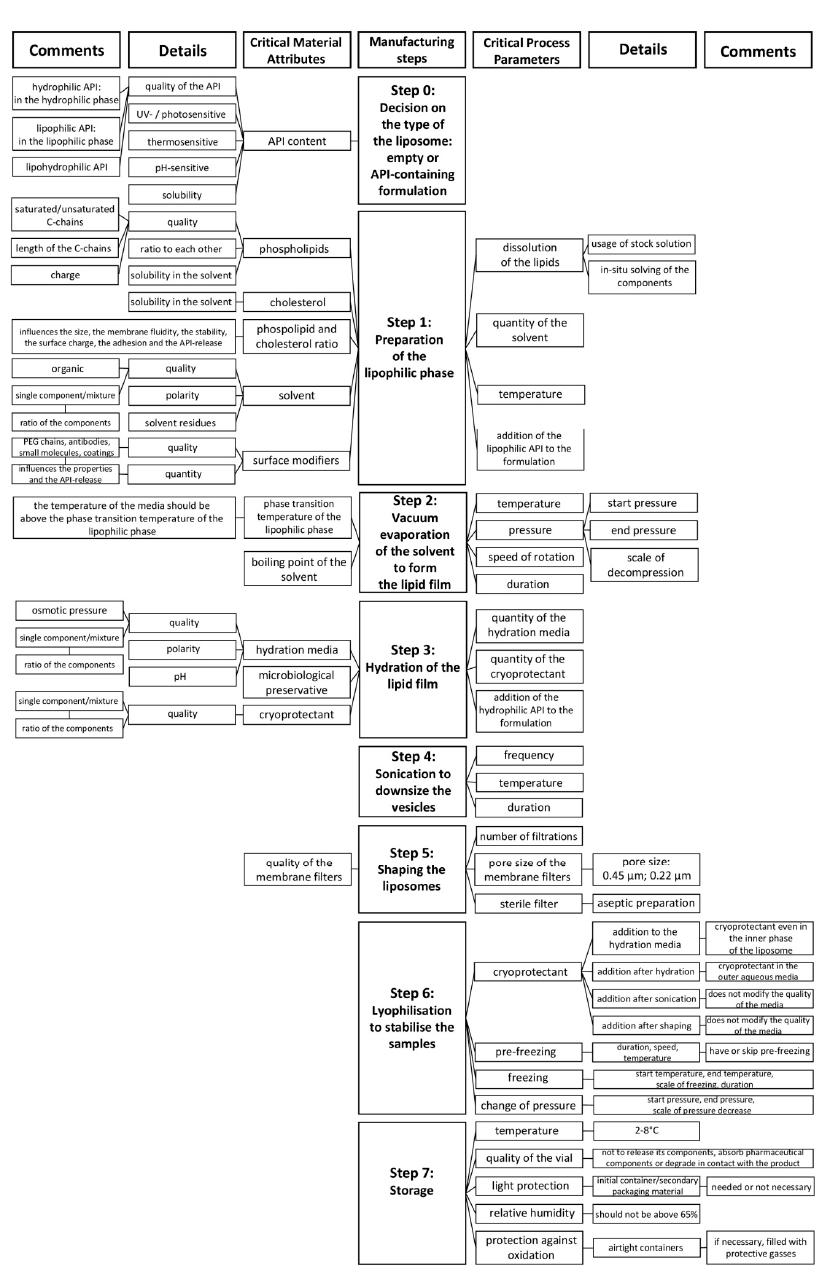
Figure 2. Collection of the properties of the liposome components (material attributes (MAs)) and the preparation method (process parameters (PPs)) that a ff ect the result of the thin-film hydration liposome manufacturing